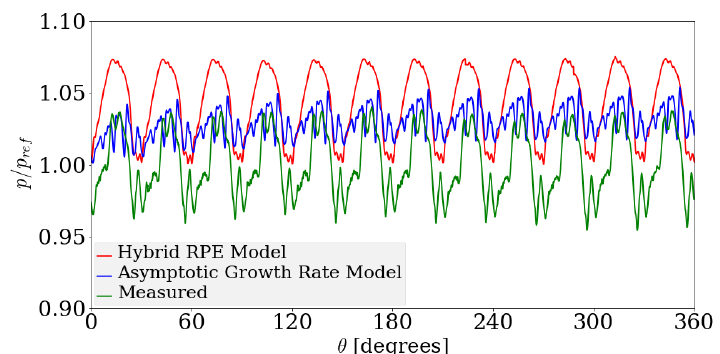
Figure 21. Comparison between delivery pressure ripple for the Asymptotic Growth Rate model, the Hybrid Rayleigh–Plesset Solution approach with experimental data, for an operating speed of 2000 rpm and a suction pressure of − 0.72 bar gauge pressure. The modeled pressure fluctuations are within +7.5% and − 0.0% while the measured data is within +4.0% and − 4.5% of the reference value.